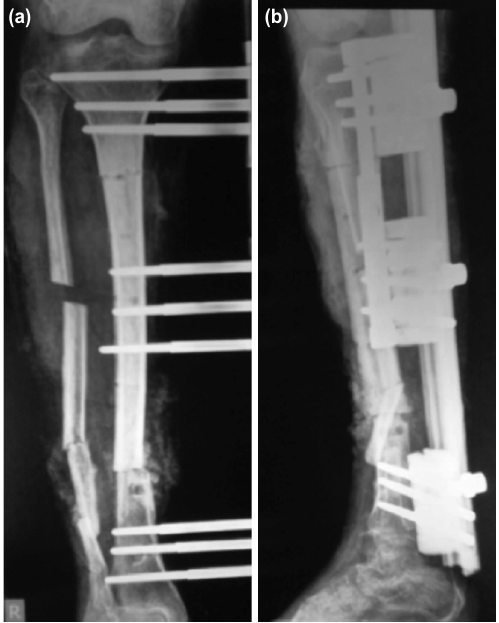
(a) Anterior posterior and (b) lateral plain radiograph Fig. 4: showing Union